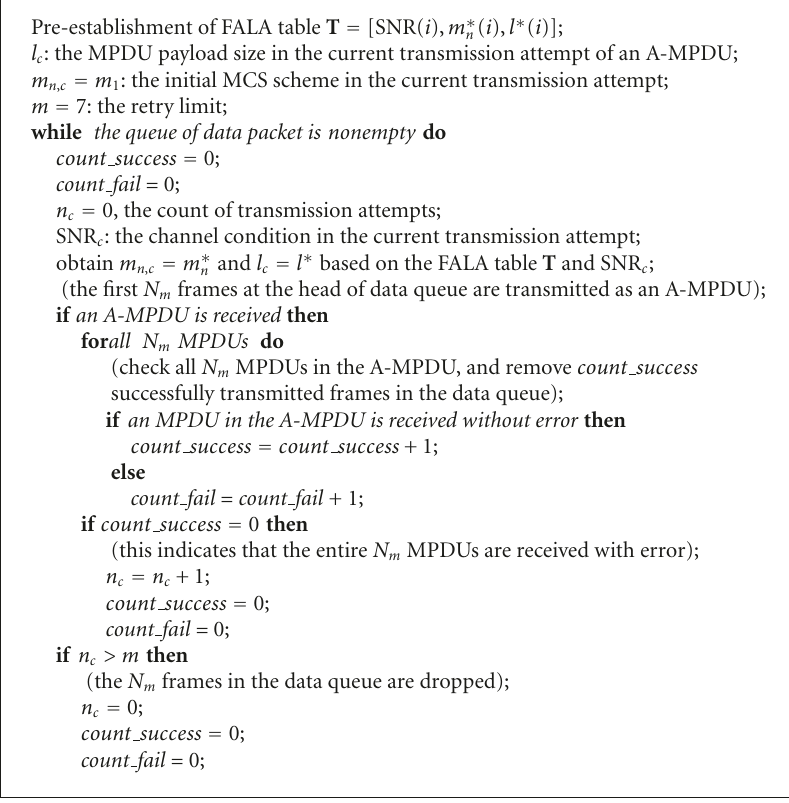
Algorithm 1: Proposed Frame-Aggregated Link Adaptation (FALA) Algorithm.